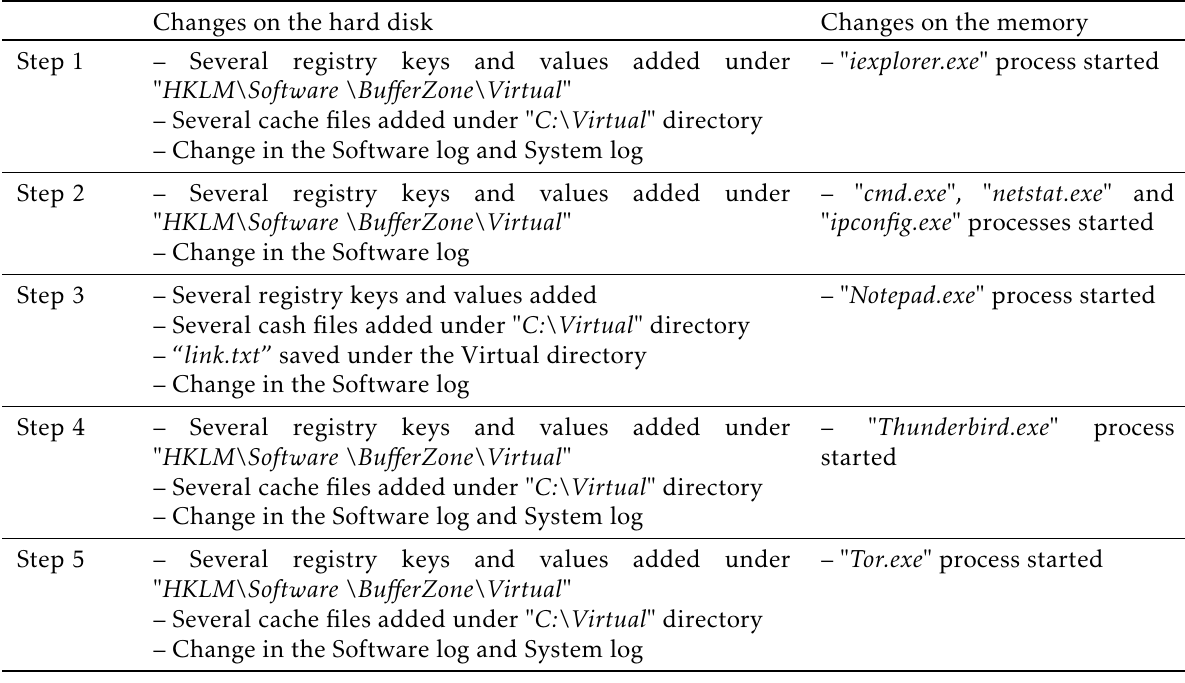
Table 4. System changes from generating user data in the experiment setup within